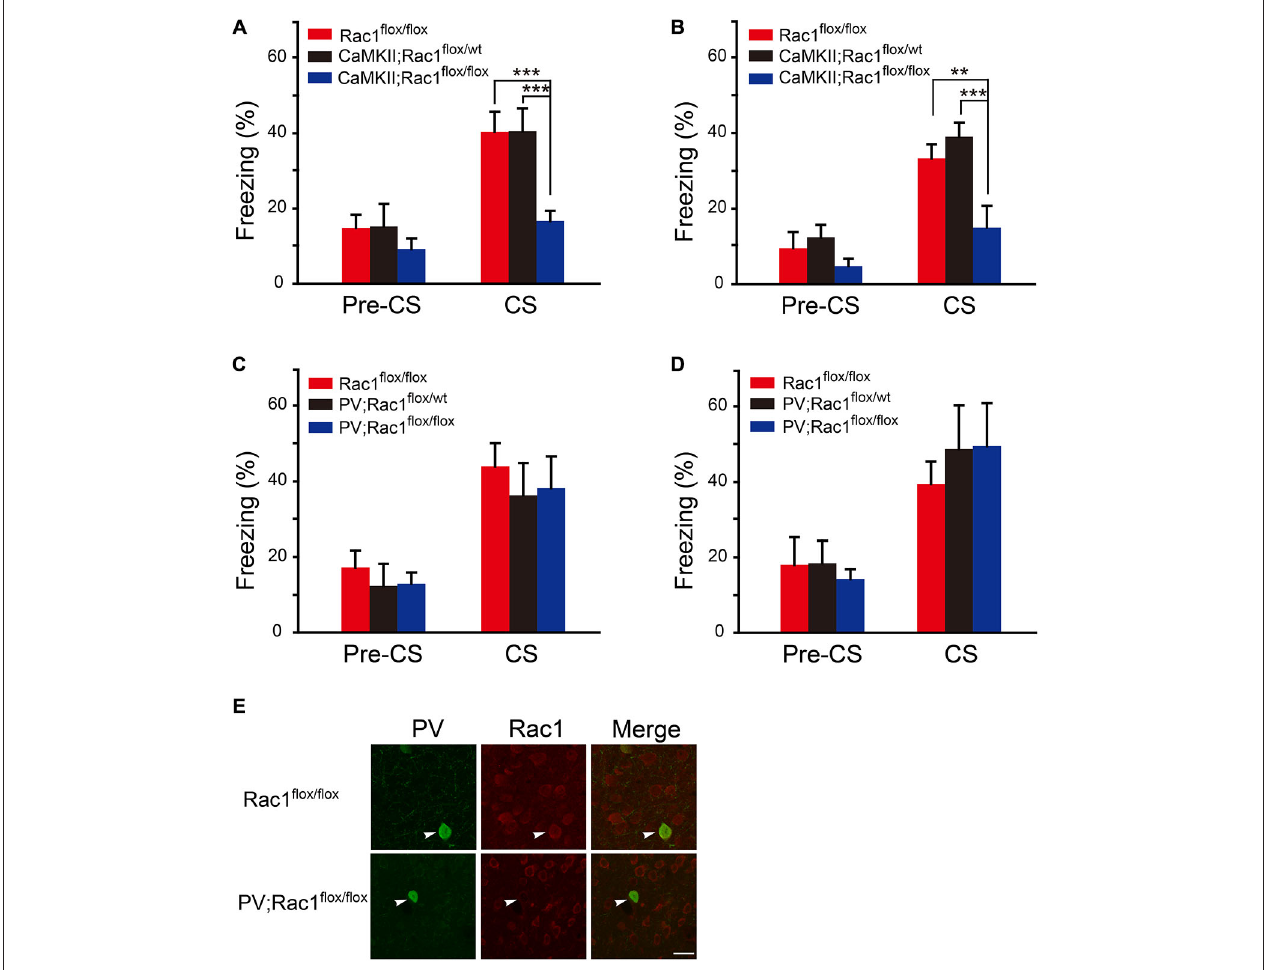
FIGURE 1 | Conditional knockout of Rac1 in CaMKII α -positive excitatory neurons impaired short-term and long-term fear memory. (A,B) Ablation of Rac1 in the CaMKII excitatory neurons decreased freezing at 1 h ( A , Rac1 flox / flox : n = 6, CaMKII; Rac1 flox / wt : n = 6, CaMKII; Rac1 flox / flox : n = 9, ∗∗∗ p < 0.001 vs. Rac1 flox / flox and CaMKII; Rac1 flox / wt group) and 24 h ( B , Rac1 flox / flox : n = 6, CaMKII; Rac1 flox / wt : n = 8, CaMKII; Rac1 flox / flox : n = 8, ∗∗ p < 0.01 vs. Rac1 flox / flox group, ∗∗∗ p < 0.001 vs. CaMKII; Rac1 flox / wt group) auditory fear memory tests. (C,D) Ablation of Rac1 in the PV inhibitory neurons did not change freezing at 1 h ( C , Rac1 flox / flox : n = 6, PV; Rac1 flox / wt : n = 8, PV; Rac1 flox / flox : n = 8) or 24 h ( D , Rac1 flox / flox : n = 6, PV; Rac1 flox / wt : n = 6, PV;Rac1 flox / flox : n = 7) auditory fear memory test. (E) Immunofluorescence staining of Rac1 (red) and PV (green) in basolateral amygdala (BLA) of PV; Rac1 flox / flox and Rac1 flox / flox mice. Scale bar: 25 µ